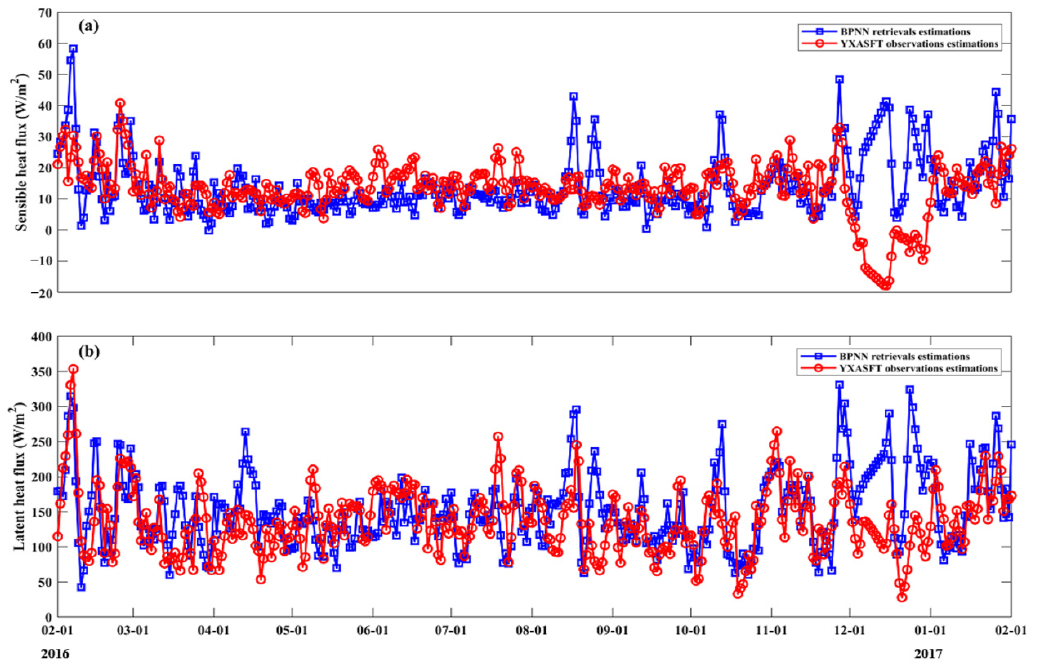
Figure 7. Daily time-series plots of the estimated heat fluxes (blue solid lines) from COARE 3.5 and BPNN − retrieved air − sea interface parameters (WS, T s , T a , RH) and YXASFT observations (red solid lines) over a period of 1 year (from 1 February 2016 to 31 January 2017): ( a ) sensible and ( b ) latent heat flux.